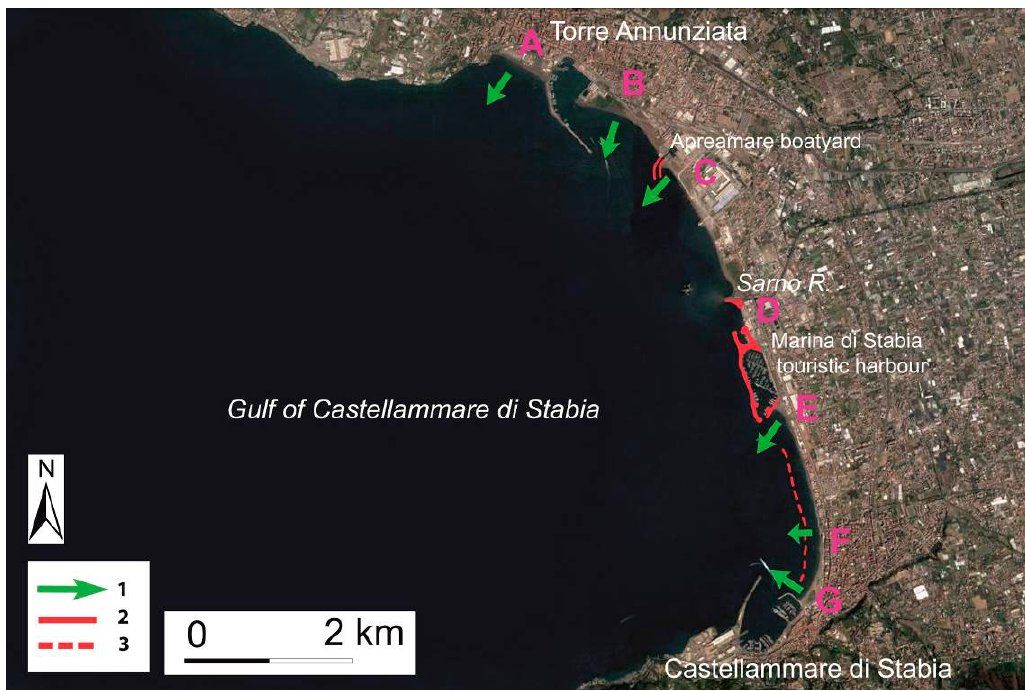
Figure 8. Shoreline response after the built up of coastal engineering works (the letters indicate the stretches of the beach that are under progradation). Legend: (1) progradational beaches; (2) coastal engineering works; (3) detached submerged breakwaters.